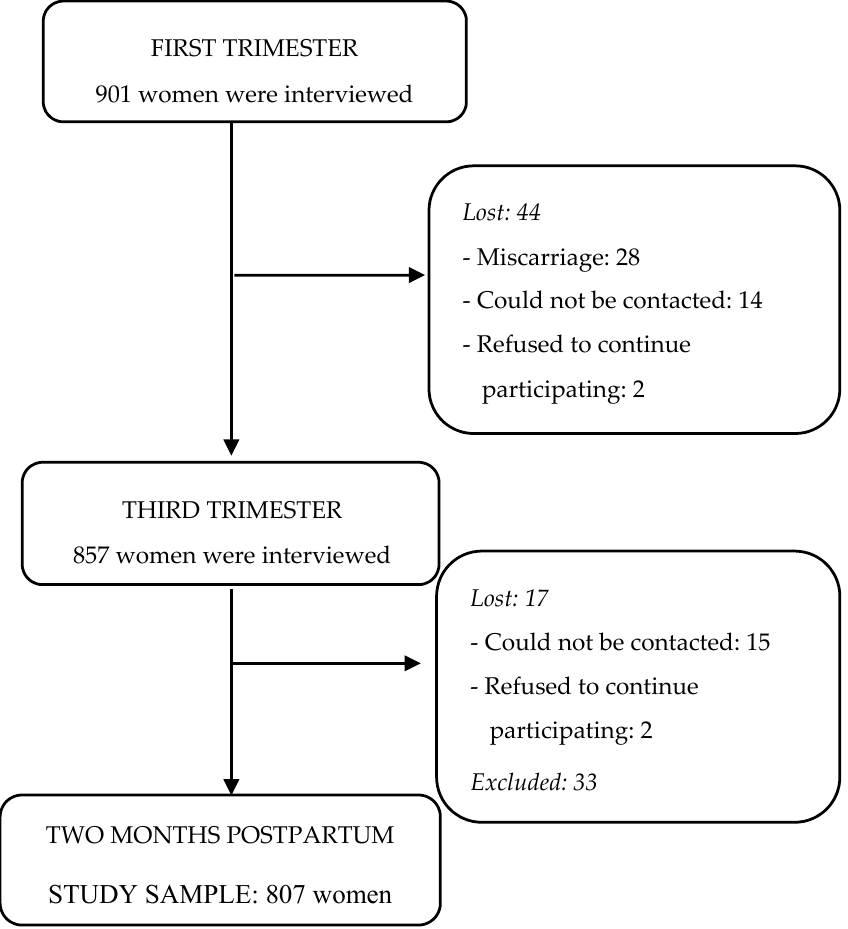
Figure 1. Flow diagram of recruitment and progress through study.